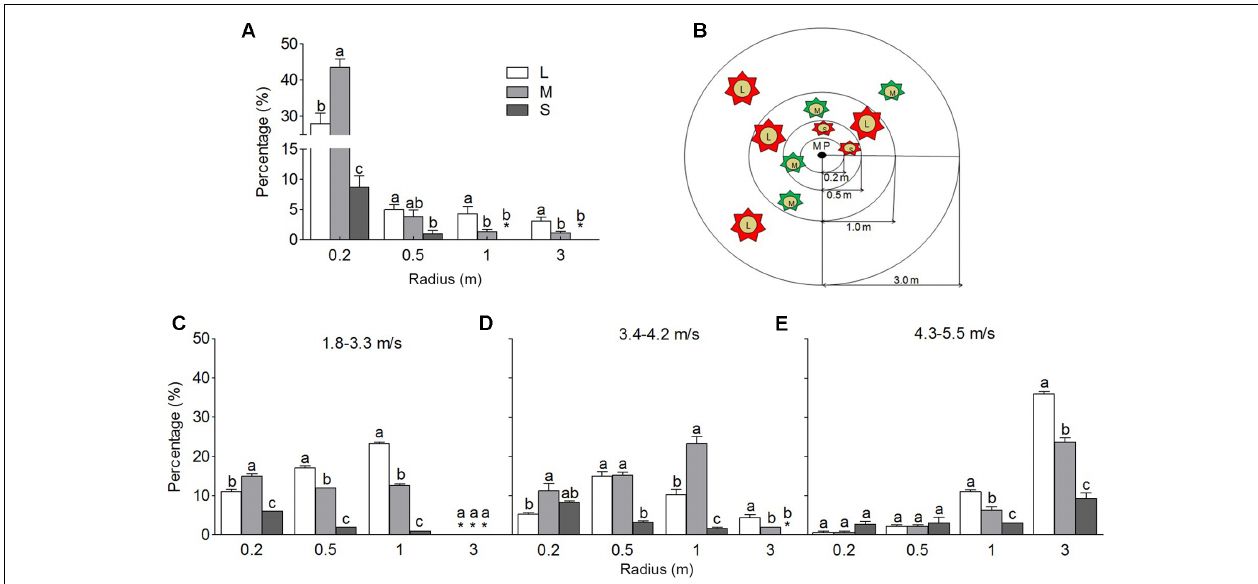
FIGURE 6 | Dispersal patterns of heteromorphic seeds of S. ferganica surrounding mother plant in natural habitat or under control wind force in laboratory. Four circles with radius of 0.2, 0.5, 1.0, and 3.0 m were established around each mother plant, the number of seeds dispersed into each circle were recorded and the proportion of heteromorphic seeds in mother plant was calculated. (A) Percentage of heteromorphic seeds dispersed into different zones surrounding mother plant in natural habitat. (B) Schematic diagram of dispersal pattern of heteromorphic seeds. L, M, S: large, middle, small seed. 0.2, 0.5, 1.0, and 3.0 m: circles with radius of 0.2, 0.5, 1.0, and 3.0 m. (C–E) Artificial seed dispersal experiment, showing ten thousand of heteromorphic seeds were dispersed into four different radius circles at 0.2, 0.5, 1.0, and 3.0 m in laboratory, and the proportion of heteromorphic seeds was calculated. 1.8–3.3, 3.4–4.2, and 4.3–5.5 m · s − 1 : different level of wind velocity. ∗ represents the value of zero. Bars with different lowercase letters indicate significant differences ( P < 0.05) according to the Tukey’s test. Values are means ± SE of six replicates in (B) , or four replicates in (C–E)